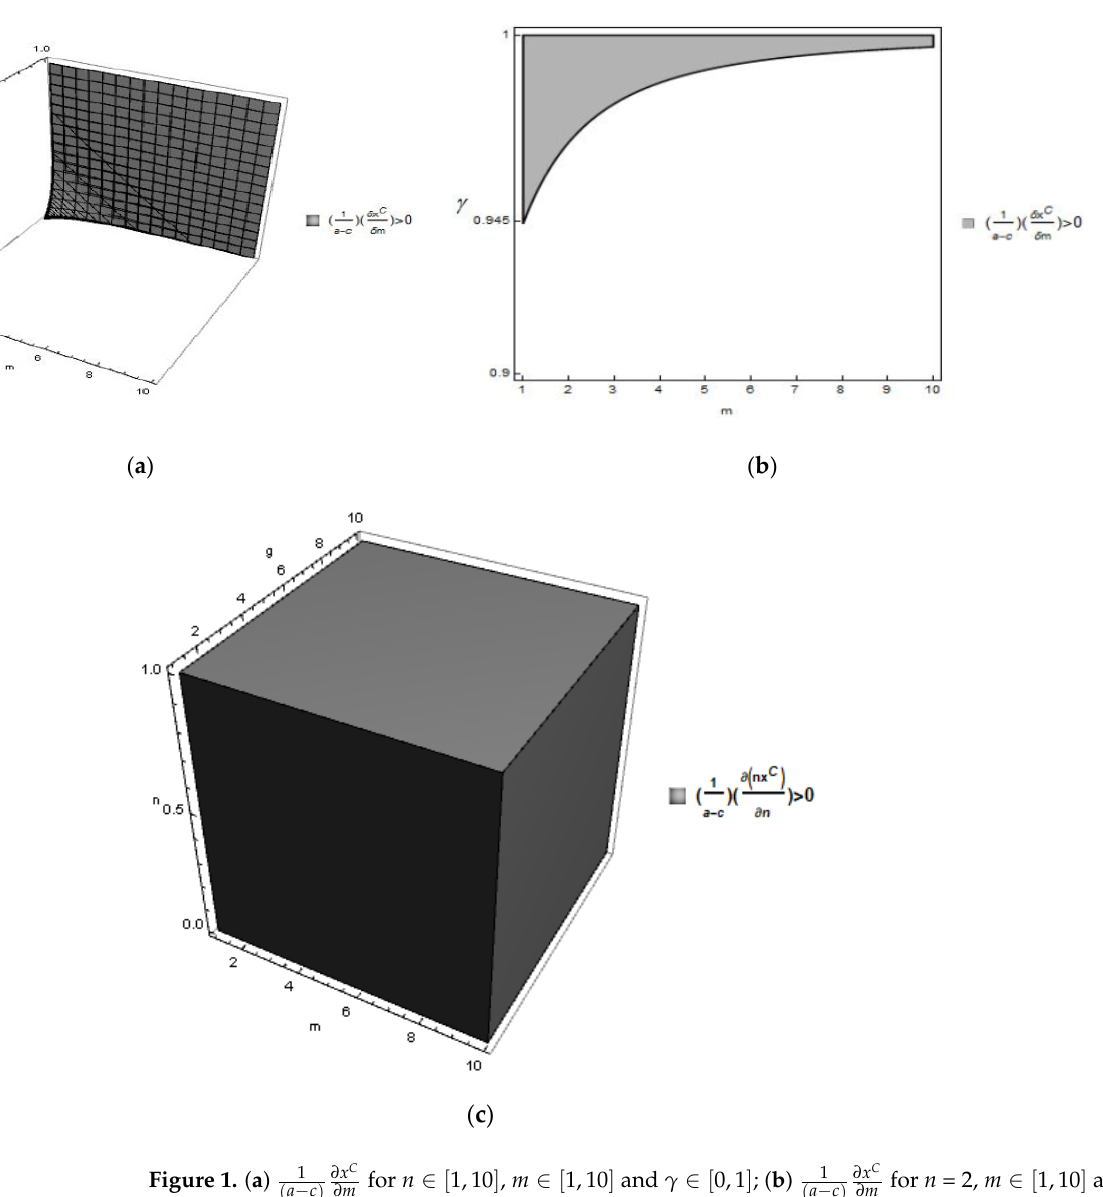
Figure 1. ( a ) (cid:2869) and 𝛾 ∈ [0.9,1] ; ( c ) (cid:2869)